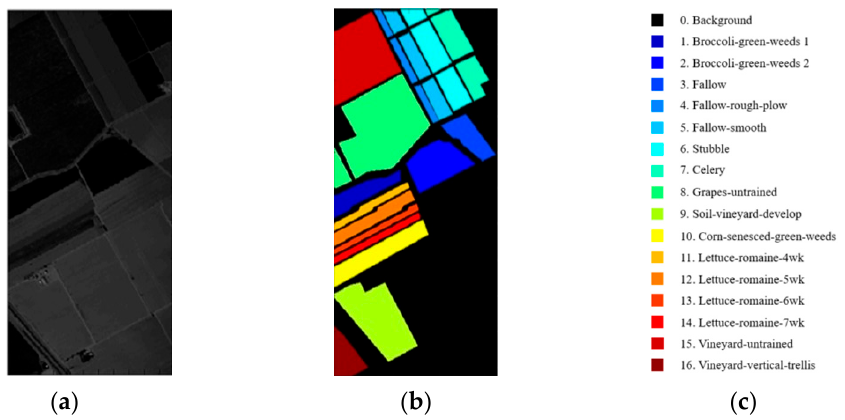
Figure 6. Salinas image scene. ( a ) Band 170th; ( b ) Ground truth map; ( c ) Ground truth class labels.